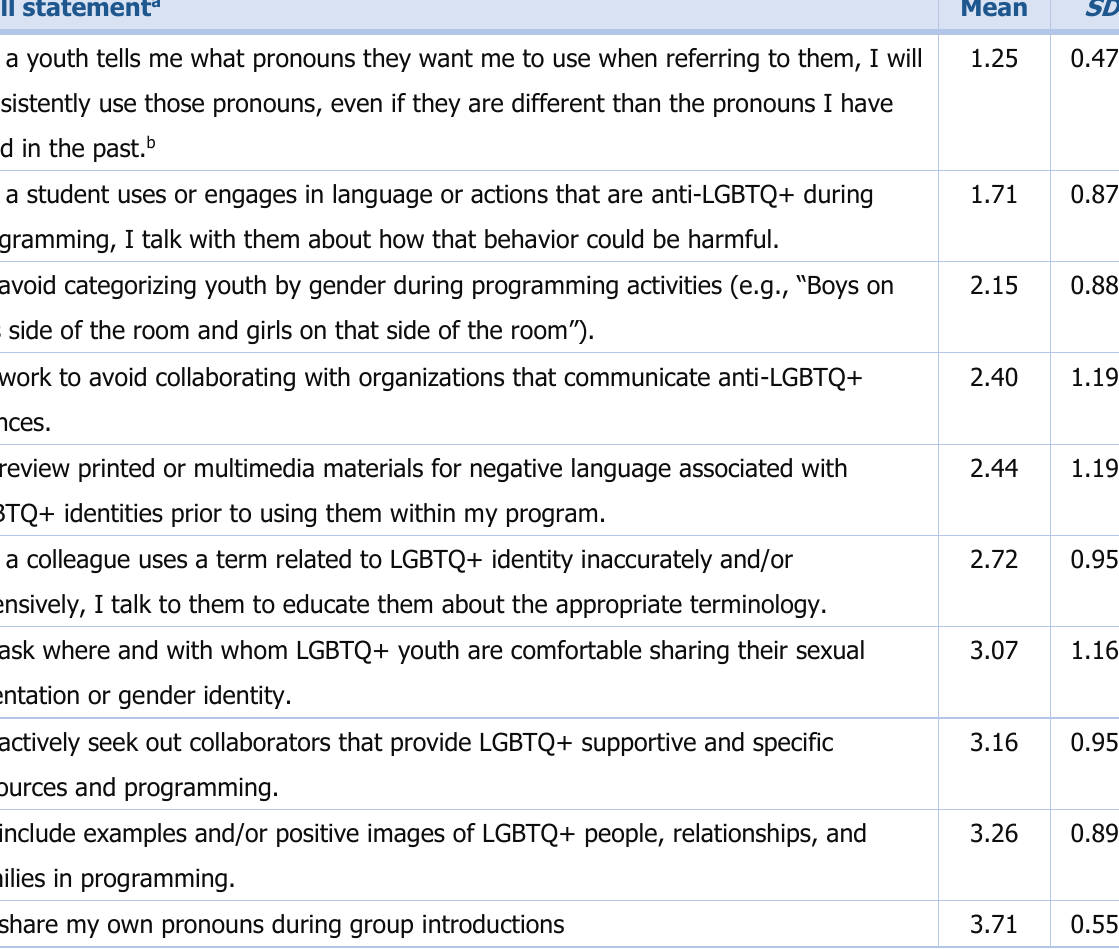
Table 3. Means and Standard Deviations of Respon dents’ Ratings on Their Skills Skill statement